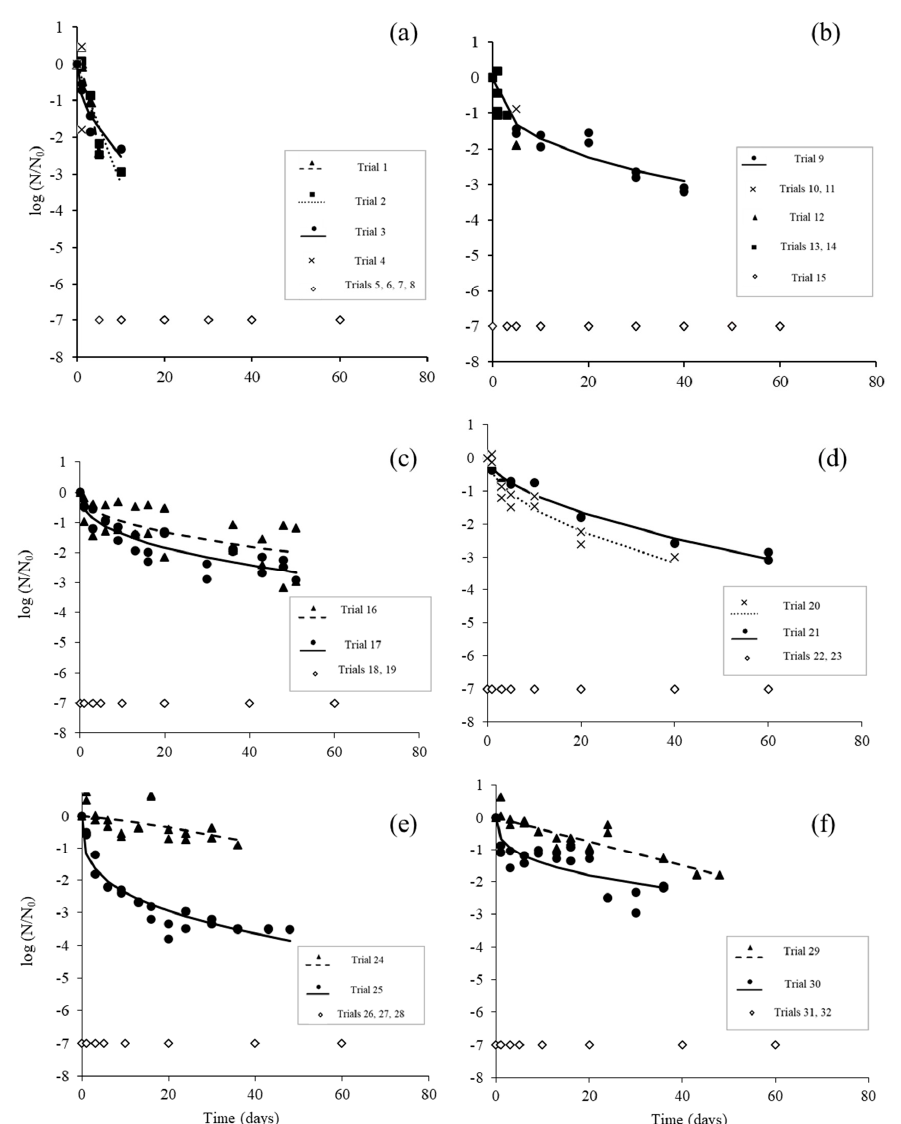
Figure 2. Salmonella survival and inactivation during storage at 7 °C of pressurized dry-cured ham (DCH) with an a w of ( a ) 0.870–0.915, ( b ) 0.919–0.920, ( c ) 0.940, ( d ) 0.950, ( e ) 0.960, and ( f ) 0.980. Symbols correspond to log change values and lines to the fit of the Weibull model (Equation (2)) to the data. Empty symbols correspond to replicates where the pathogen was not detected.